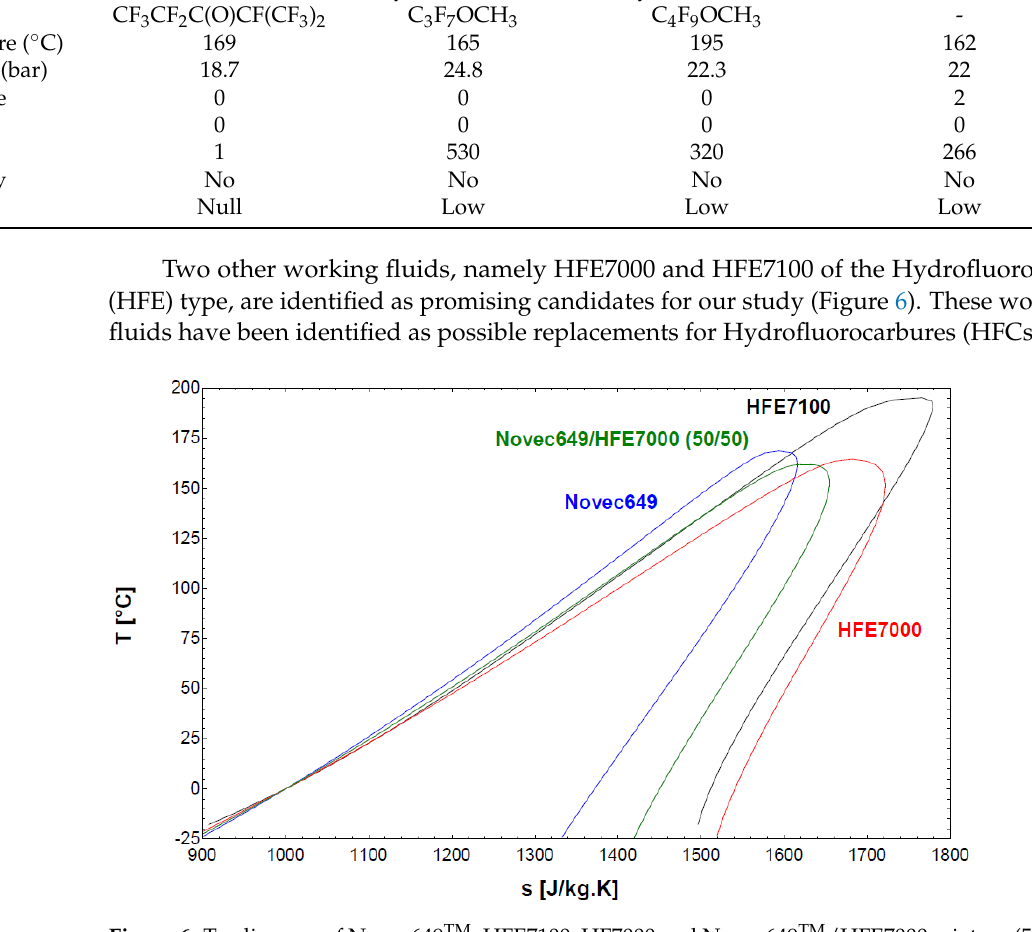
Figure 6. T-s diagram of Novec649 TM , HFE7100, HF7000 and Novec649 TM /HFE7000 mixture (50/50). Table 2. Main properties of the working fluids studied.